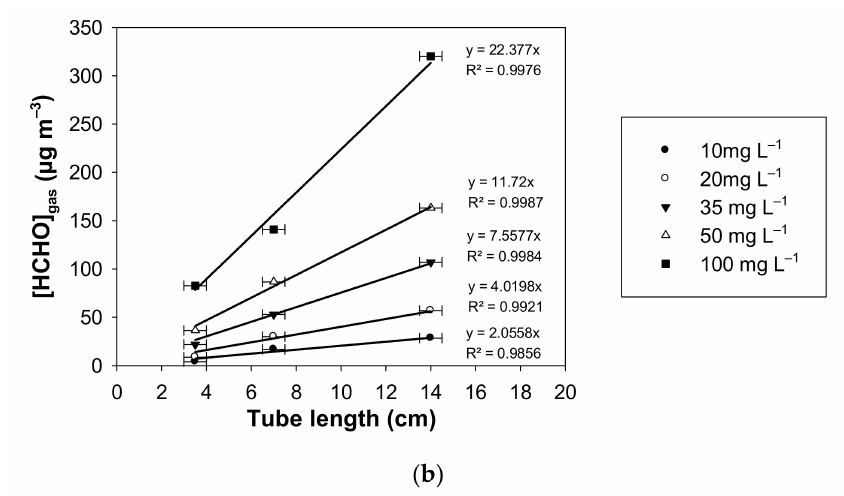
Figure 8. Generated gaseous formaldehyde concentration and relative humidity measured with a formaldehyde analyser ( µ F1, Chromatotec, Val-de-Virv é e, France) for different tube lengths (L = 3.5 cm in purple, L = 7 cm in blue and L = 14 cm in green), with [HCHO] liq = 0–100 mg L − 1 , F gas = 100 mL min − 1 , T = 10.7 ◦ C, photomultiplier gain = 50%. The horizontal error bars correspond to the uncertainties calculated from the preparation of the liquid formaldehyde solution. The vertical error bars correspond to two times the standard deviation, but they are too small to be visible.